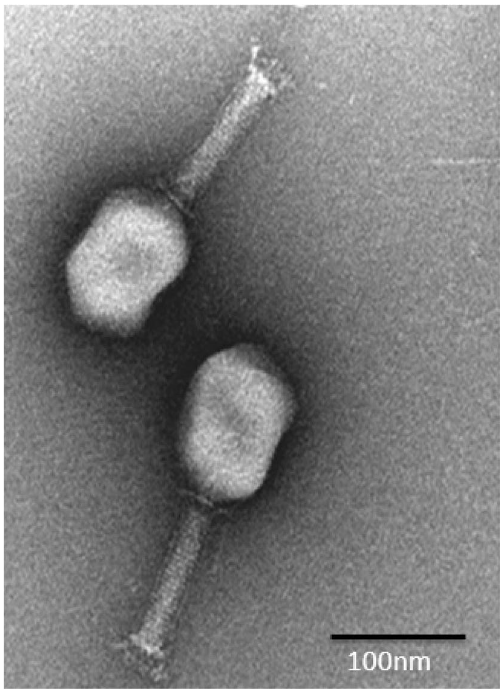
Figure 1. Negatively stained image of bacteriophage particles showing a prolate head, long contractile tail and a baseplate. Scale bar-100